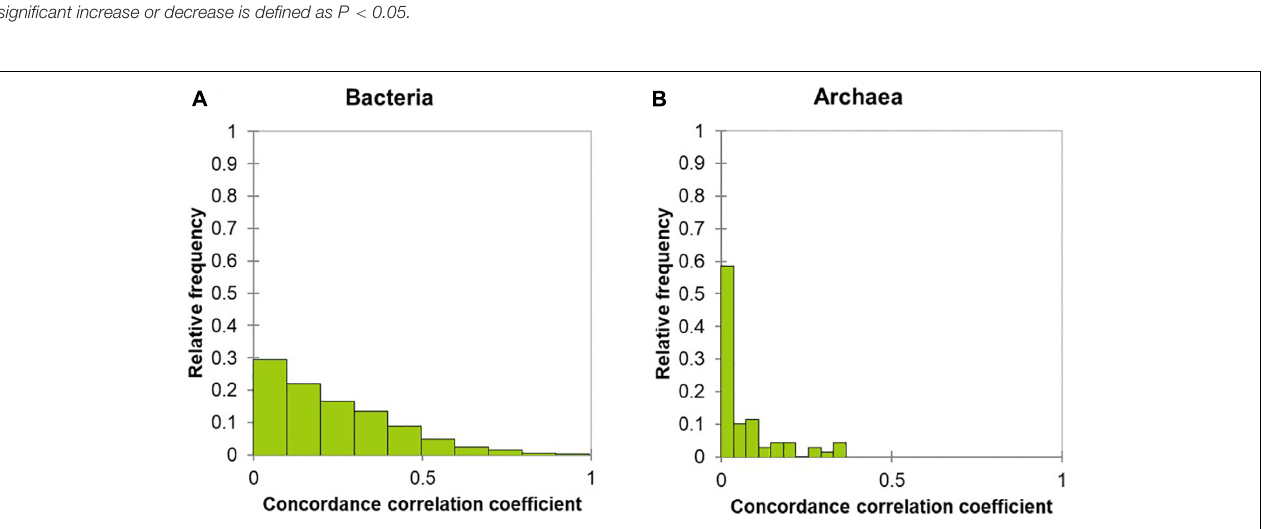
FIGURE 3 | Stability assessment of the rumen bacterial and archaeal communities. The calculation of concordance correlation coefficient (C value) is described in the statistical analysis section and percentages of OTUs with similar C value are displayed. An OTU with C value greater than 0.5 and P value of Pearson correlation coefficient smaller than 0.05 is denoted as “stable,” as indicated by red dash line, otherwise “unstable.” Consequently, the C value distribution of 6,363 bacterial OTUs (A) and 79 archaeal OTUs (B) are shown in bar